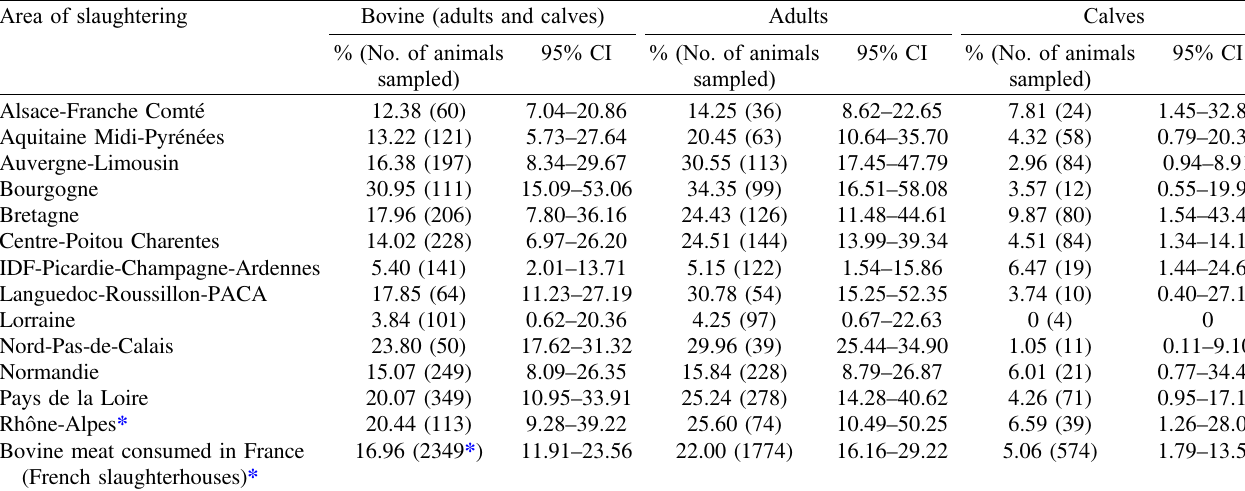
Table 6. Seroprevalence of Toxoplasma gondii infection (cut-off titer 6) in bovine meat consumed in France by area of birth. Area of slaughtering Bovine (adults and calves)